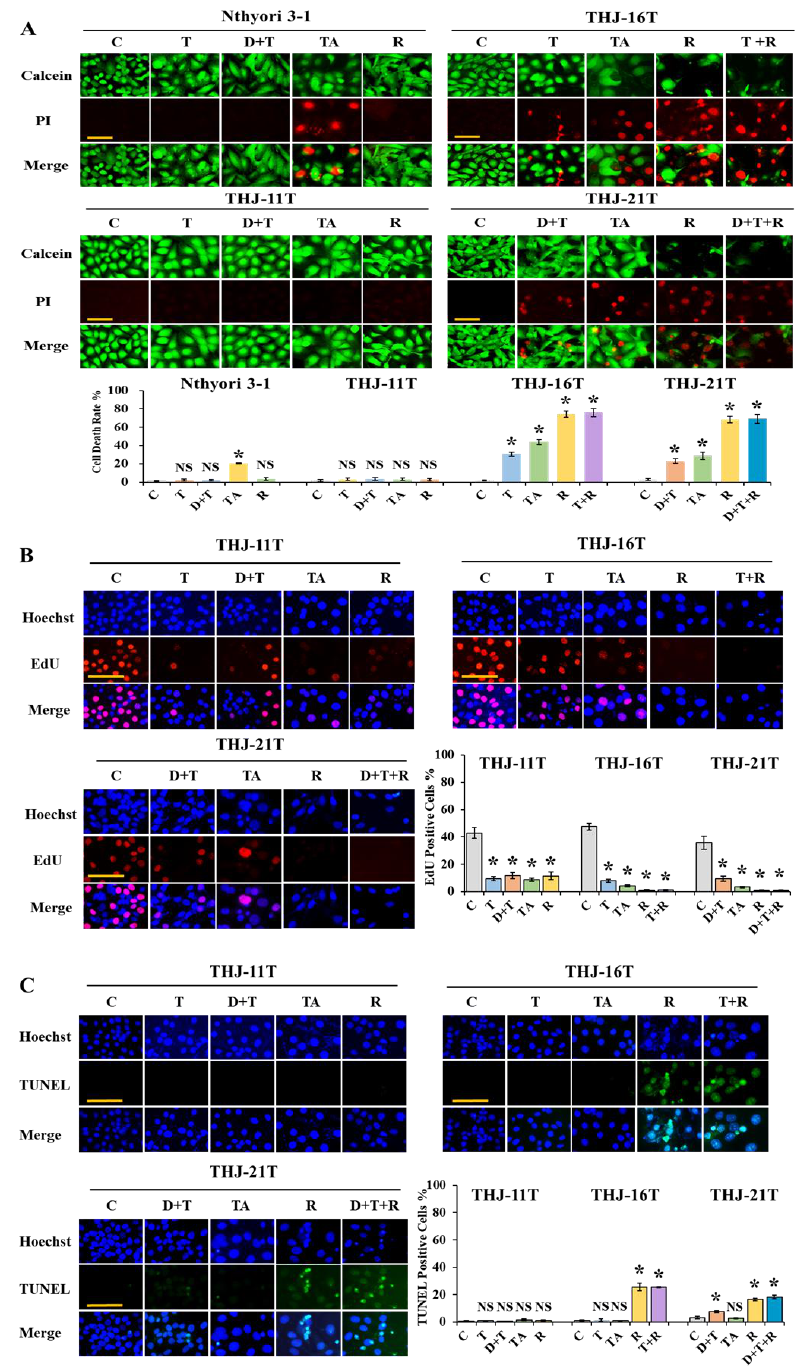
Figure 1. Drug response of Nthyori 3-1, THJ-11T, THJ-16T, and THJ-21T cells. ( A ) Calcein/PI cell viability assay of Nthyori 3-1, THJ-11T, THJ-16T, and THJ-21T cells after 48-h drug treatments (Scale bar, 100 µ m). NS, without statistical significance ( p > 0.05). The statistical significance was set at * p < 0.01; the error bars, the mean ± standard deviation (SD). ( C ), cultured in 0.2% DMSO containing medium as control; T, trametinib; TA, docetaxel and doxorubicin; D+T, dabrafenib and trametinib; R, resveratrol; T+R, trametinib and resveratrol; D+T+R, dabrafenib, trametinib, and resveratrol. ( B , C ) EdU cell proliferation assay and TUNEL apoptotic cell labeling (Scale bar, 100 µ m) were performed on THJ-11T, THJ-16T, and THJ-21T cells after 48 h drug